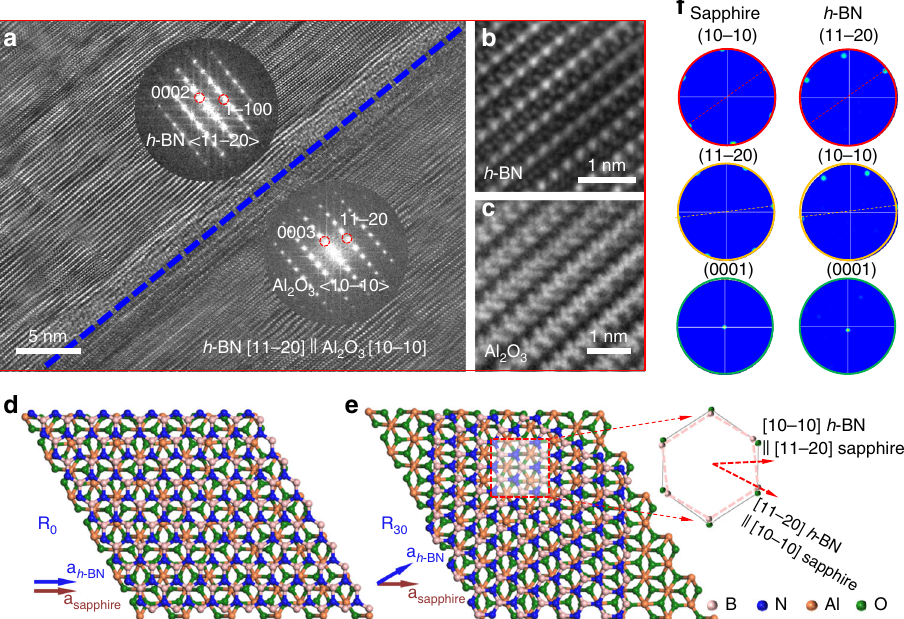
Fig. 3 Epitaxial relationship between multilayer h -BN and sapphire. a High-resolution TEM image of <11-20> h -BN multilayers on sapphire along <10 – 10> of sapphire. The inset shows the corresponding FFT pattern from multilayer h -BN and sapphire areas, respectively. b , c TEM images with atomic resolution of multilayer h -BN ( b ) and sapphire ( c ). d , e Atomic arrangement of the h -BN layer on the sapphire substrate without rotation (R 0 ) and with a rotational angle of 30° (R 30 ). f EBSD pole fi gures in the (0001), (10 – 10), and (11 – 20) planes for c -plane sapphire substrate and multilayer h